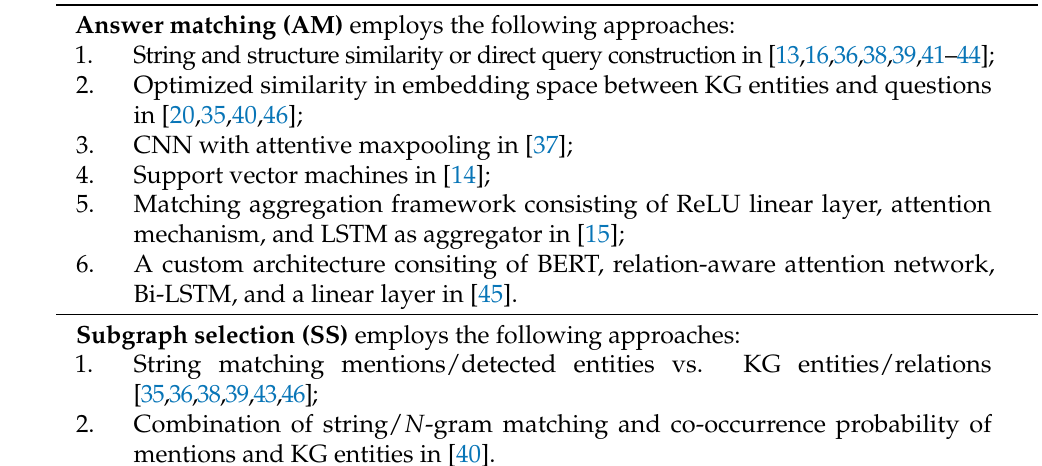
Table 3. Models/approaches employed for answer matching and subgraph selection